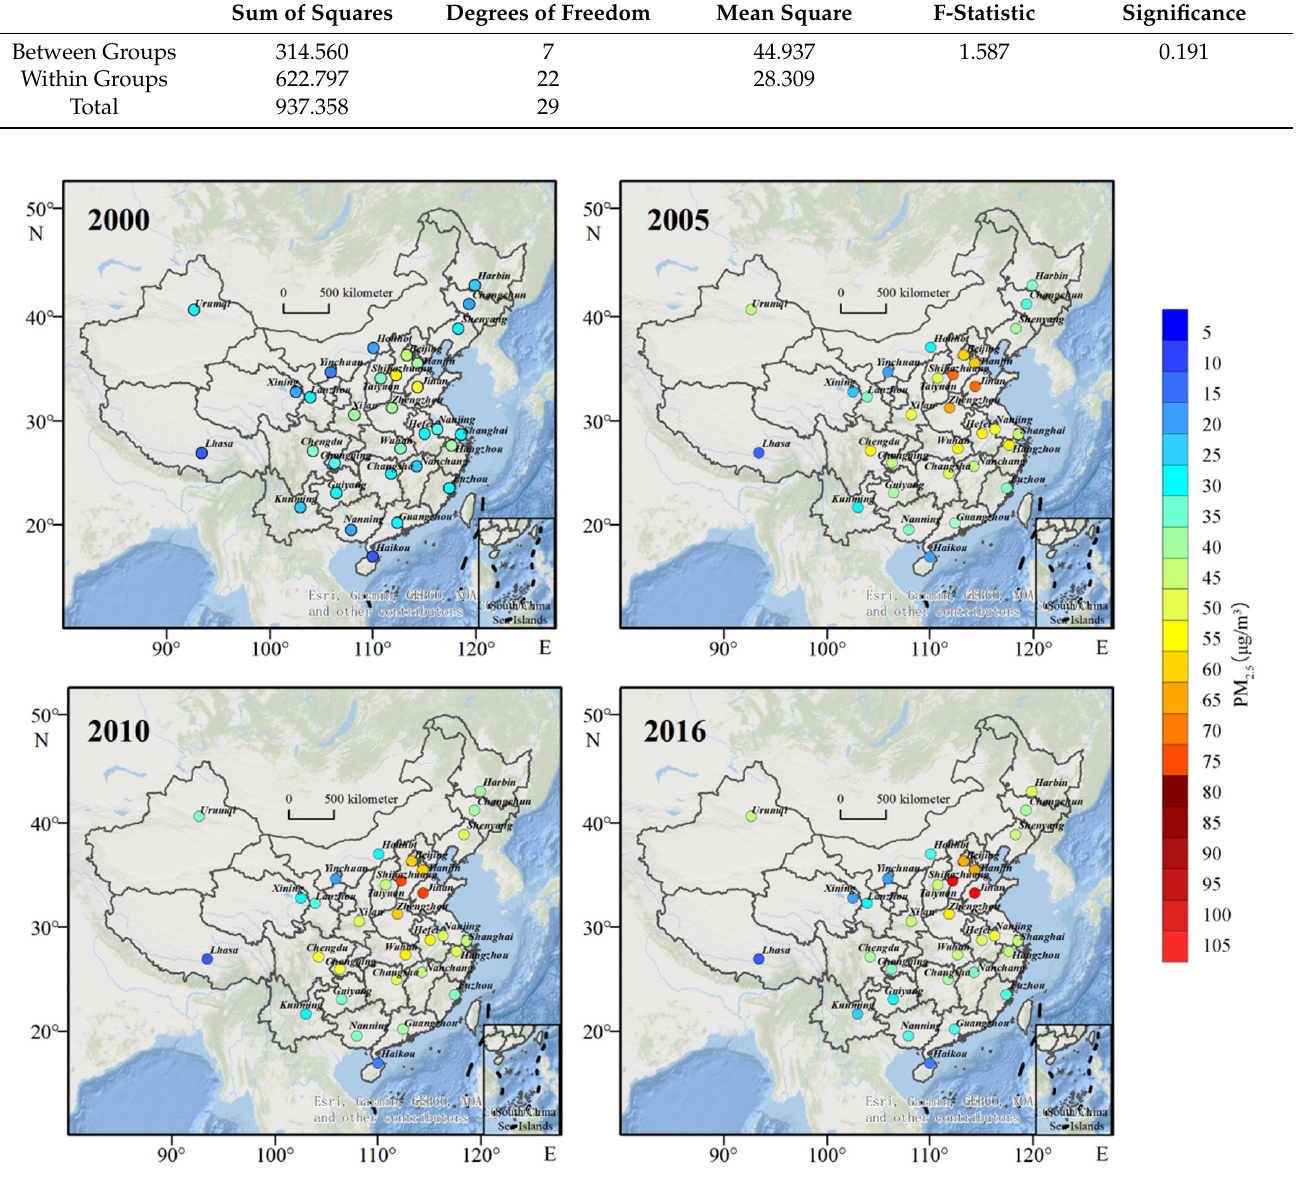
Figure A2. The change of population in three terms of 2000–2005, 2005–2010 and 2010–2016.